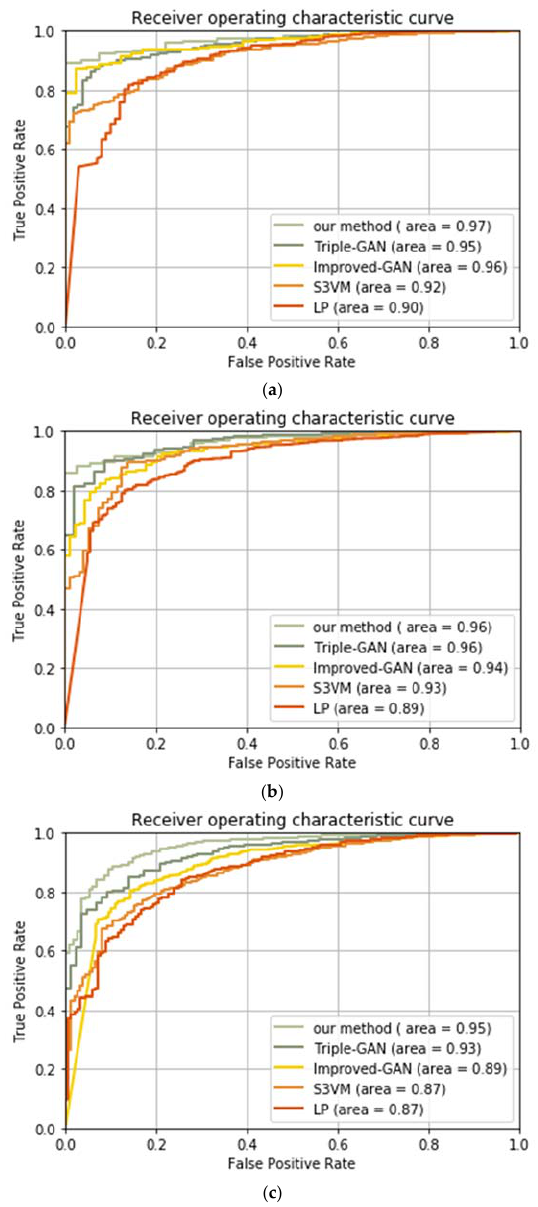
Figure 7. Receiver operating characteristic (ROC) curves of recognition accuracy: ( a – c ) correspond to 40%, 60%, and 80% unlabeled rate, respectively.